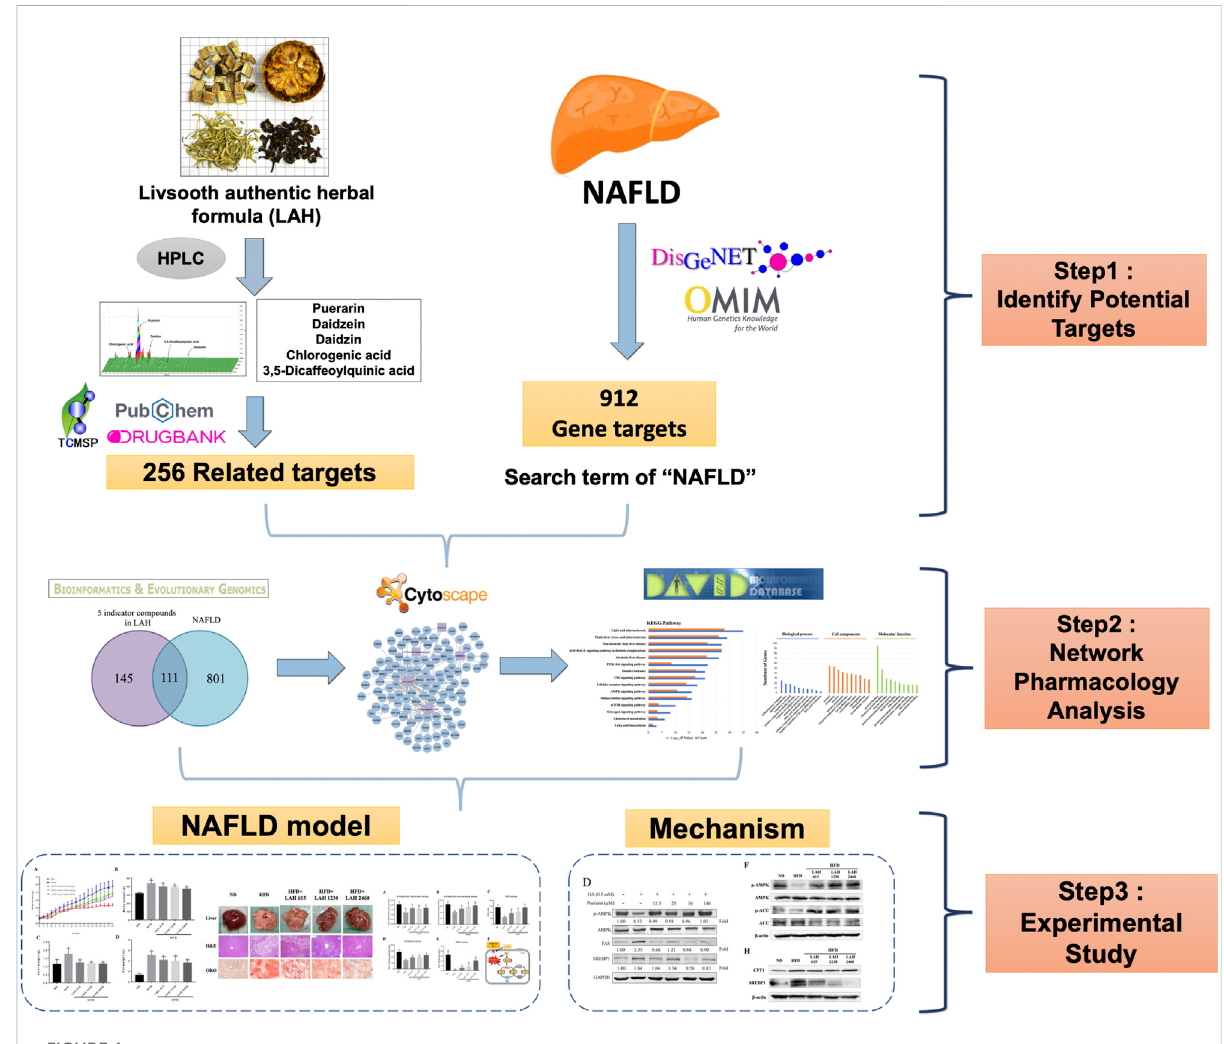
FIGURE 1 Flowchart of a network pharmacology study of LAH in the treatment of